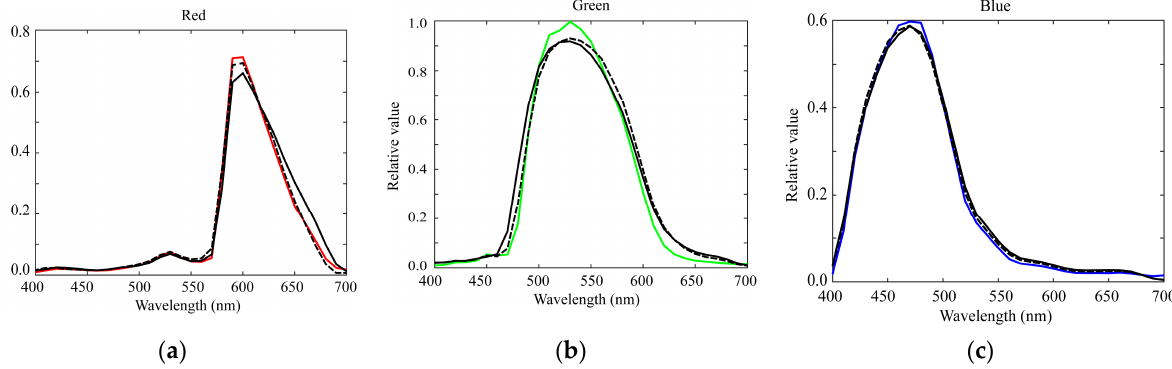
Figure 6. First three principal components u 1 , u 2 , and u 3 for the ( a ) red, ( b ) green, and ( c ) blue channels of the spectral sensitivity functions. The bold, broken, and dotted curves represent the first, second, and third principal components, respectively.